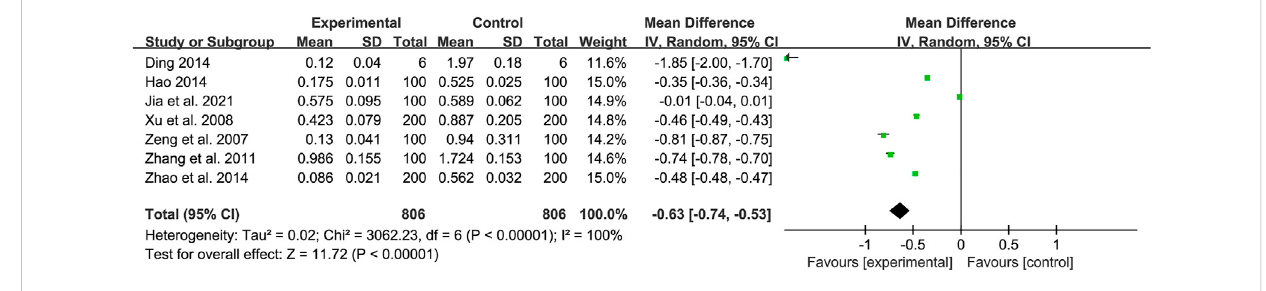
FIGURE 9 Forest map of OD value of cell proliferation.